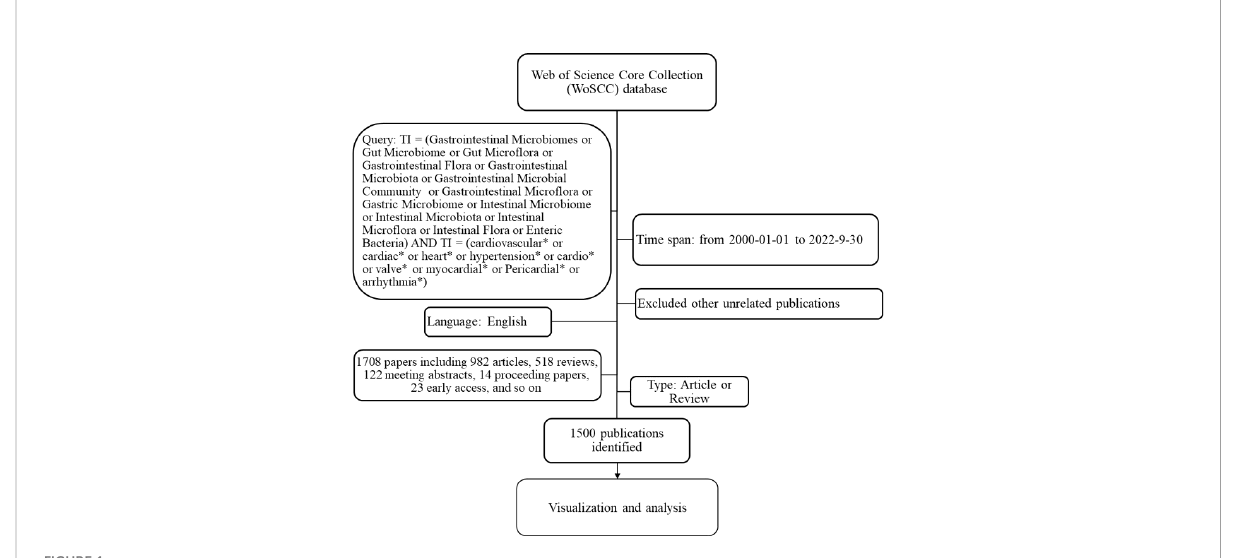
FIGURE 1 Flow chart showing the process of the selection of publications included in this